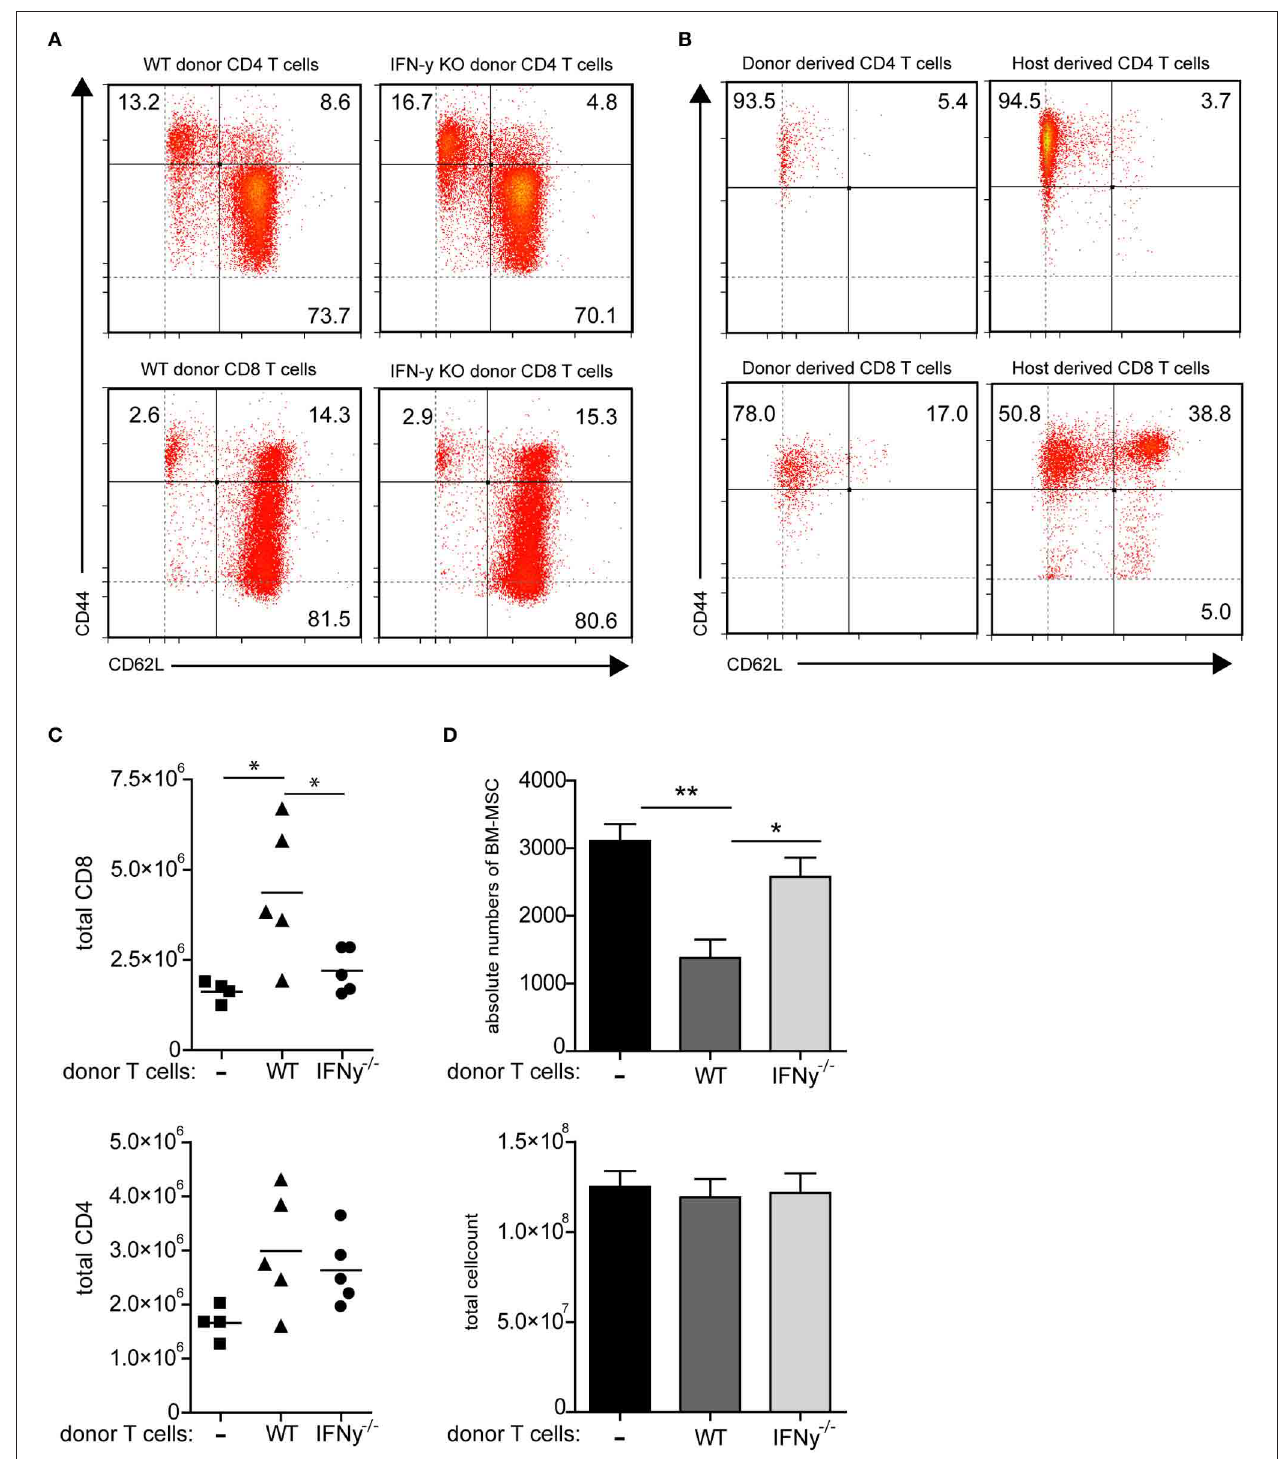
numbers of CD8 or CD4 T cells in bone marrow of CD70TGxCD27 − / − recipients that received no T cells, WT T cells or IFN-y − / − T cells. (D) Absolute numbers of MSCs and total cell count in bone marrow of CD70TGxCD27 − / − recipients that received no T cells, WT T cells or IFN-y − / − T cells. Data represent an average of 5 animals per group ( ± SEM, ANOVA, ∗ p < 0 . 05, ∗∗ p < 0 .